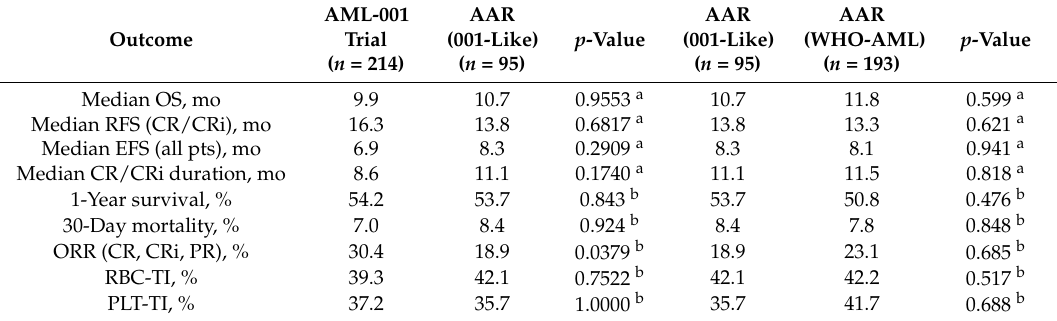
Table 3. Outcome of AML patients treated with azacitidine front-line per patient subset.